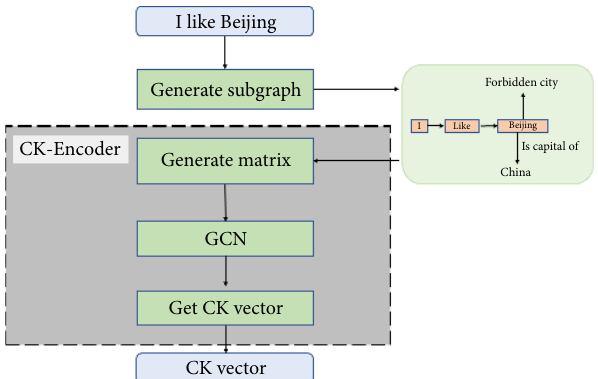
Fig. 3 Two subgraphs from commonsense knowledge graph illustrate the necessity of commonsense knowledge for sentence similarity. The words which are in the pink box make a sentence, and the rest of the words are the nodes connected to the words of the sentence in the commonsense knowledge